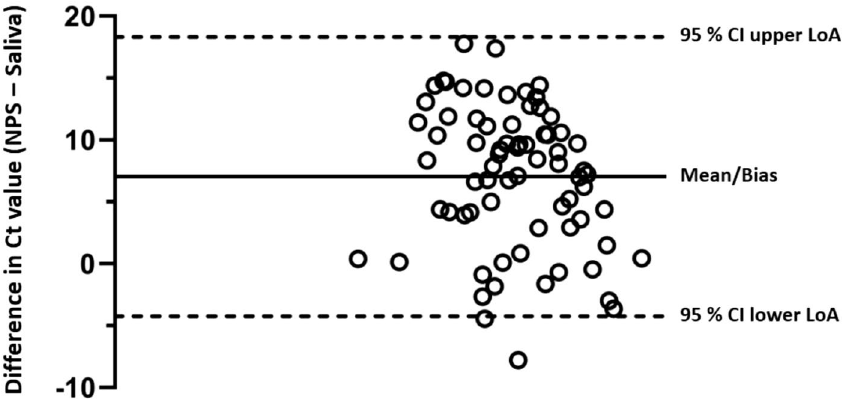
Figure 2. Scatter diagram of the differences of Ct value (NPS minus Saliva) plotted against the mean of the differences. Horizontal lines are drawn at the mean difference (7.04), 95% CI of the lower LoA (− 4.25) and upper LoA